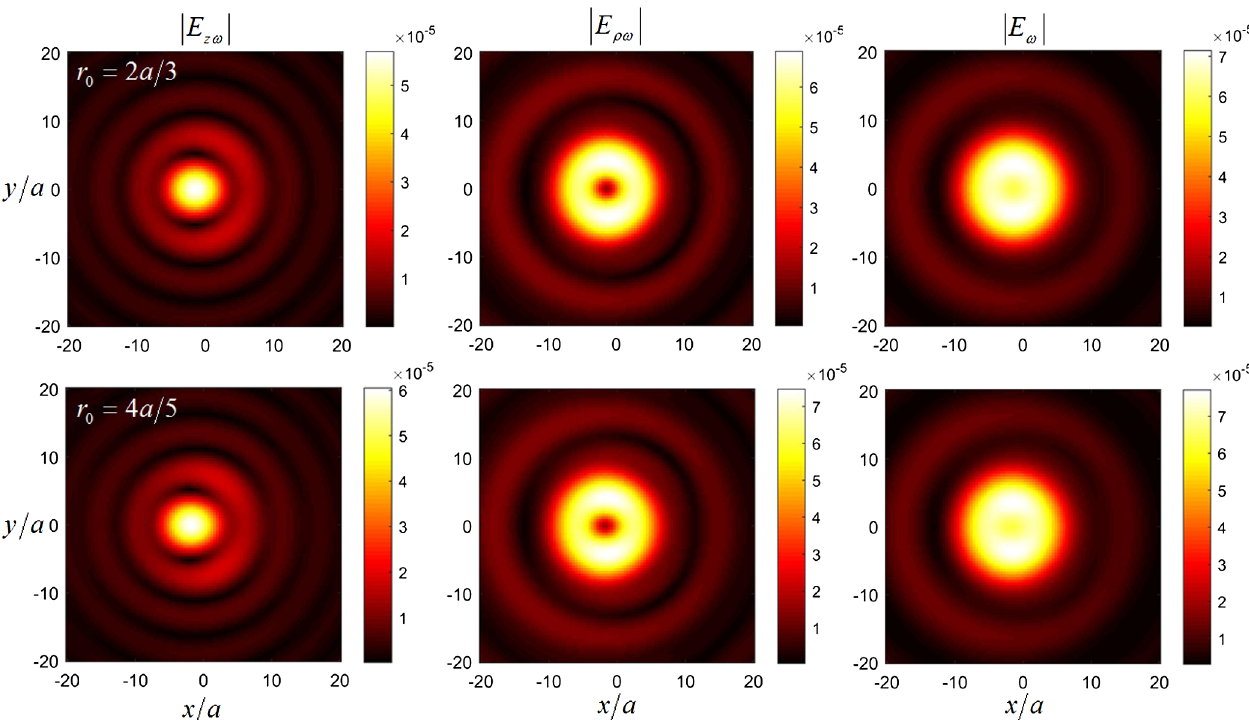
(1937).FIG. 4. Two-dimensional field distribution (electric field per unit frequency) over xy -plane ( x and y are normalized by channel radius a ) for two asymmetric cases r 0 ¼ 3 a= 4 and r 0 ¼ 4 a= 5 , φ 0 ¼ 0 , β ¼ 0 . 9 and z ¼ z same as in Fig